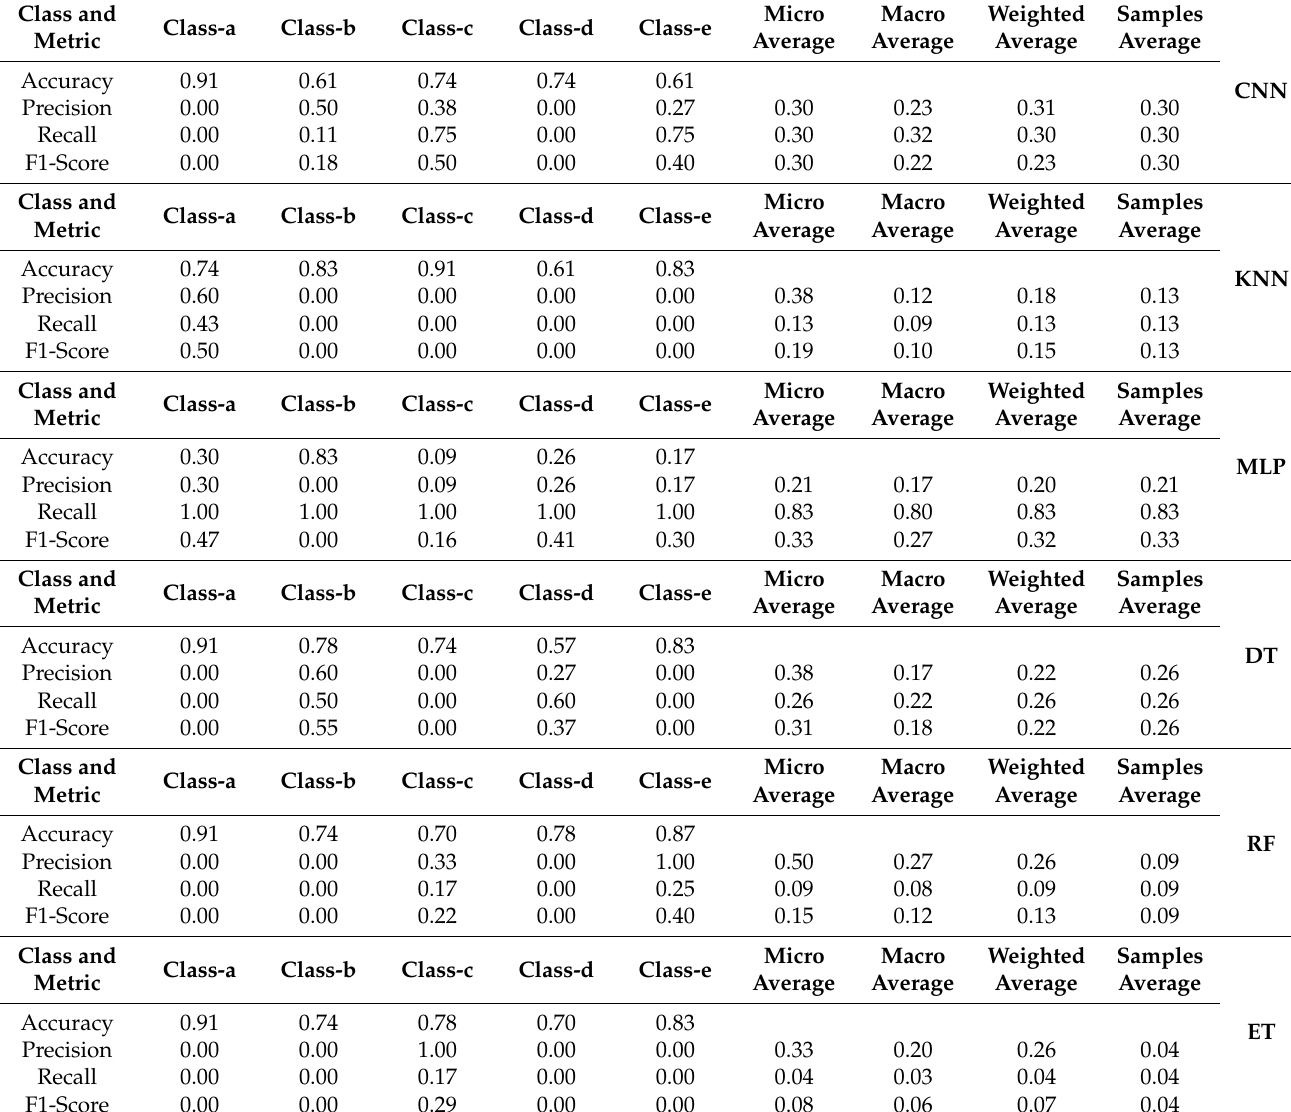
Table 4. Evaluation metrics for the CNN, KNN, MLP, DT, RF, and ET classifiers on the whole information dataset.